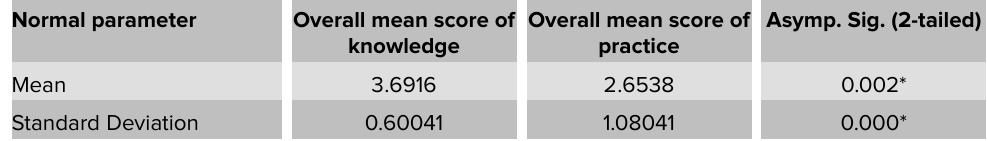
TABLE 4: Normality test in the study sample (143).